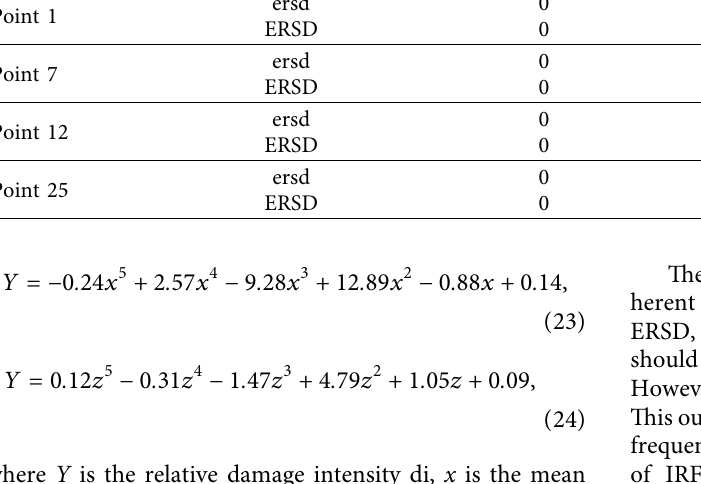
Table 7: The values of damage indexes of different points (the second time test at excitation point I).